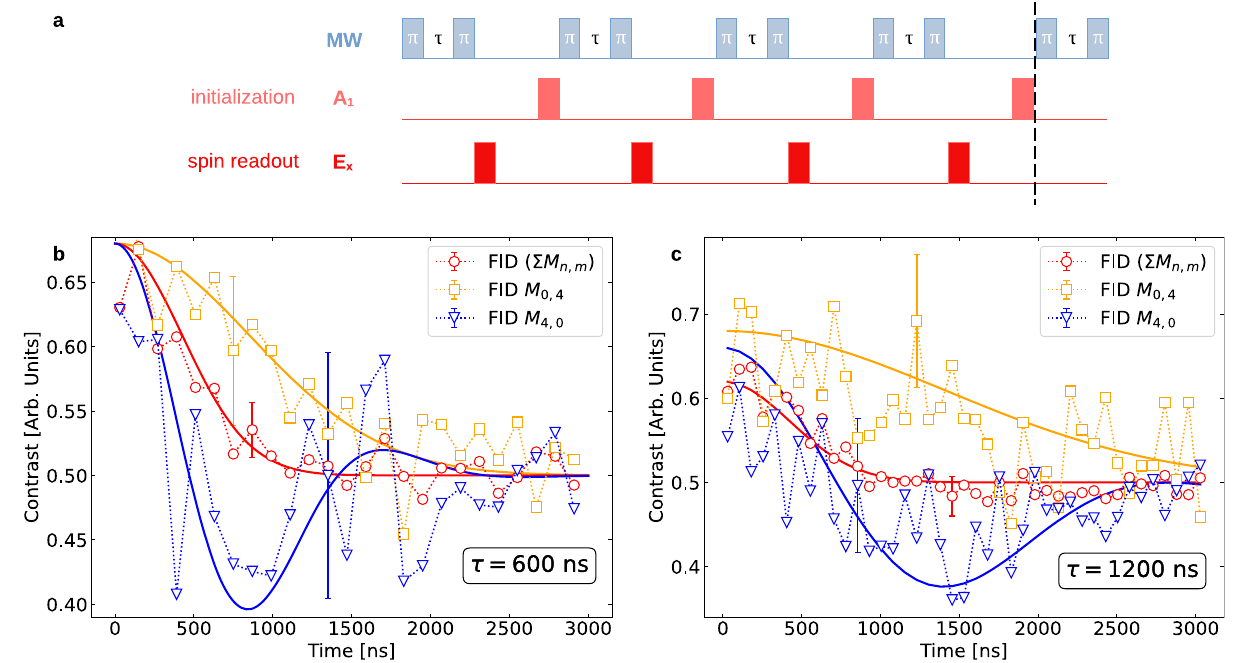
Fig.3|ZenoandAnti-Zenoeffectsontheevolutionoftheprobe-spinfollowing bath puri fi cation. a The experimental pulse diagram depicting the microwave pulses (blue) interleaved with repeated initialization ( A 1 ) and measurements ( E x ), for preparation of the bath state via CT sequence M n , m . Following the M n , m sequence, the FID of the probe spin is measured again and compared with the original FID. b , c The FID of the probe spin interacting with the puri fi ed bath state by M 0,4 (orange)and M 4,0 (blue)iscomparedwiththeaverageFIDobtainedfromall